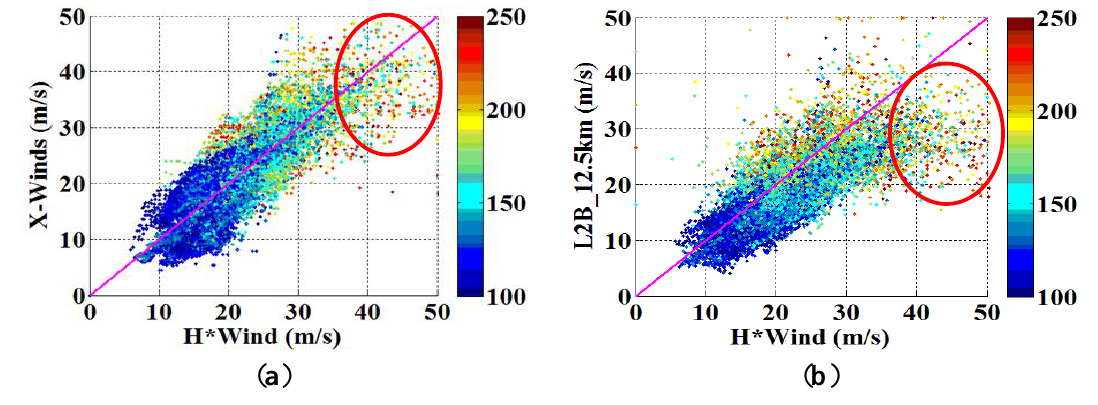
Figure 8. Wind speed comparisons with H*Wind for composite of 10 QuikSCAT hurricane revolutions: ( a ) is X-Winds and ( b ) is L2B-12.5 km. Color scale denotes the QRad H-pol brightness temperature (warm colors indicate